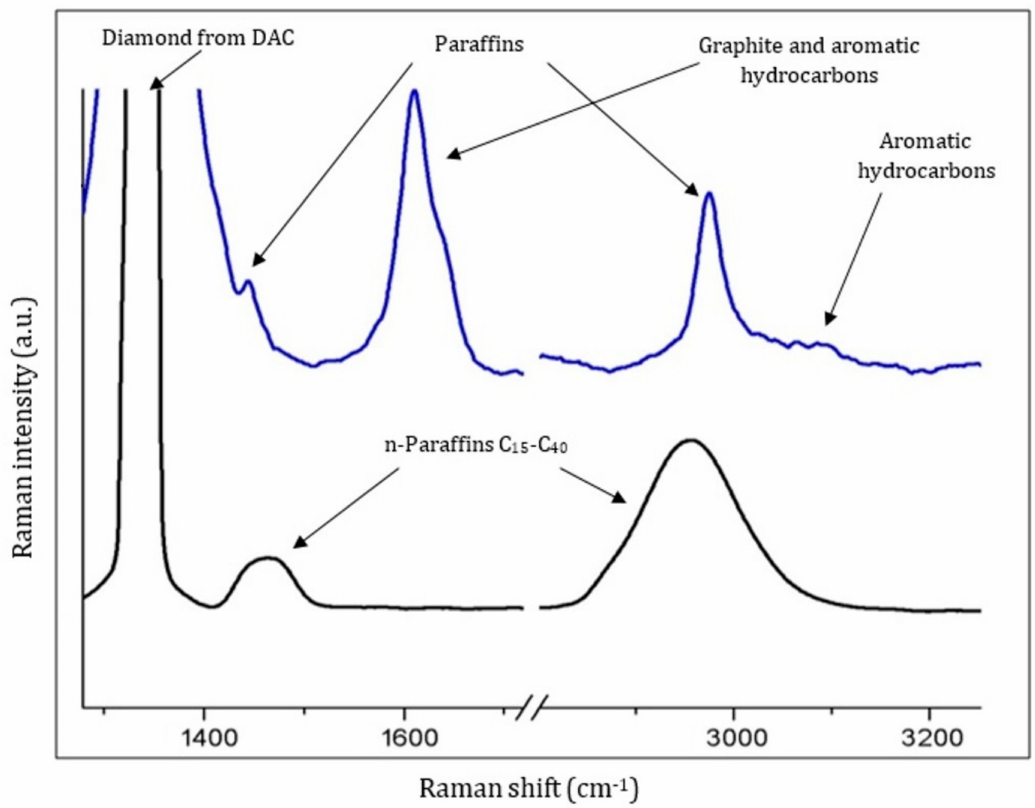
Figure 1. Examples of Raman spectra of para ffi n oil + ferropericlase compressed to 7.4(0.2) GPa at ambient temperature ( black curve ), and after laser heating at 1200(100) K ( blue curve ). Some of the new Raman peaks can be interpreted as being due to graphite [22]. However, the characteristic modes of n-alkanes (which may be di ff erent from the starting material) are still present, and there are indications that new, probably aromatic, hydrocarbons are formed